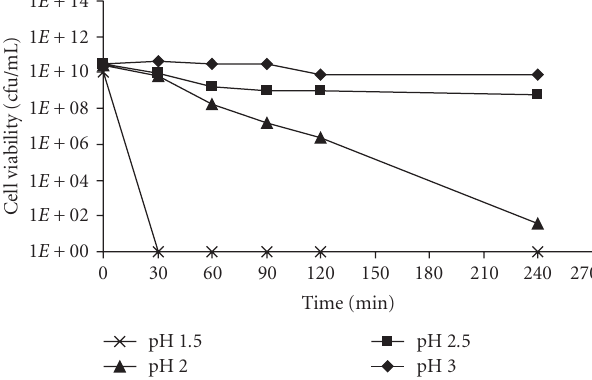
Figure 6: Viability of microencapsulated L. plantarum 80 BSH + cells in simulated stomach at pH 1.5, 2.0, 2.5, and 3.0, 37 ◦ C and 100 RPM agitation.